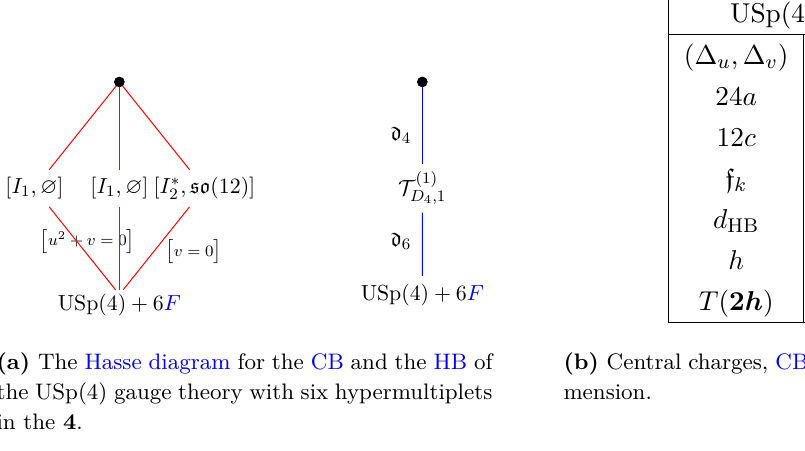
Figure 7. Information about the USp(4) N = 2 theory with six hypermultiplet in the